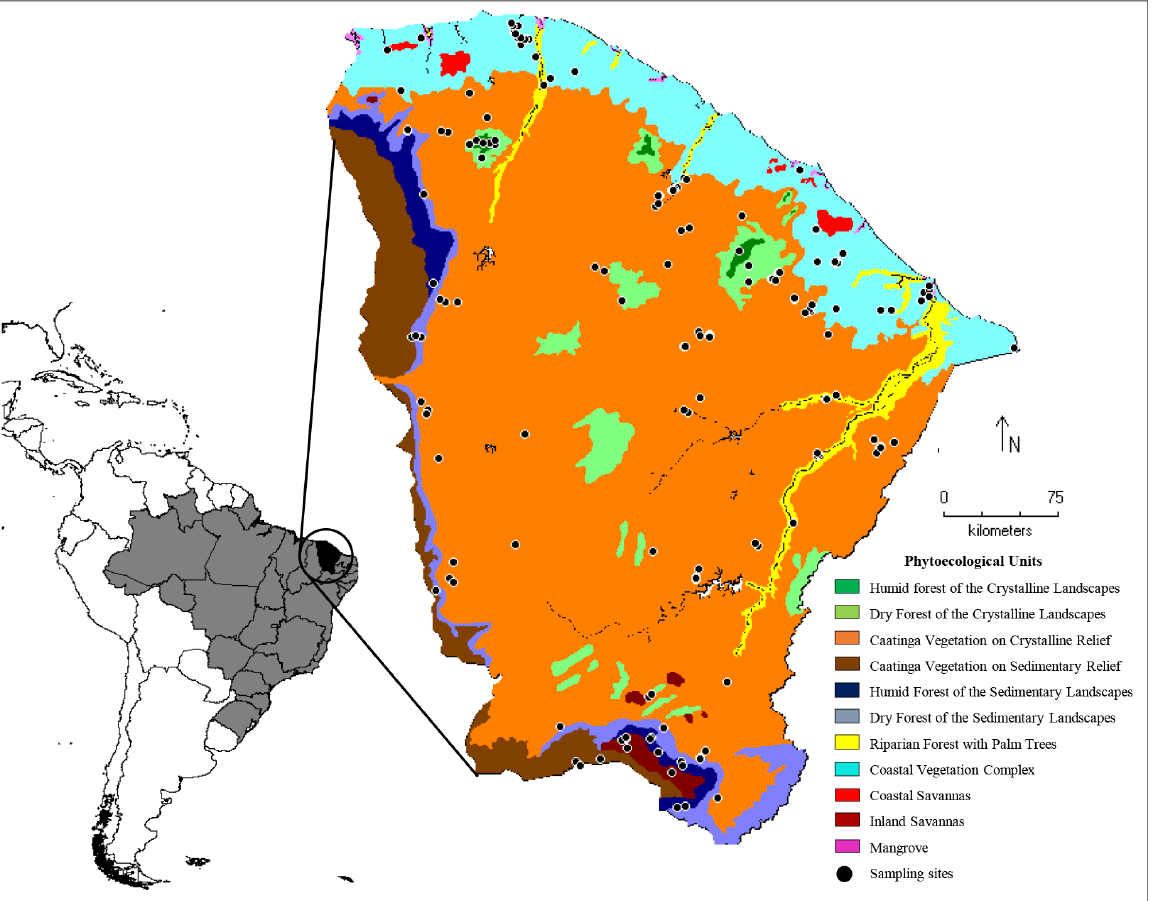
Figure 1. Map of the eleven Phytoecological Units and sampling sites of meliponines (Hymenoptera: Apidae: Meliponini) in the State of Ceará in 2013 and 2014. Adapted from Moro et al.